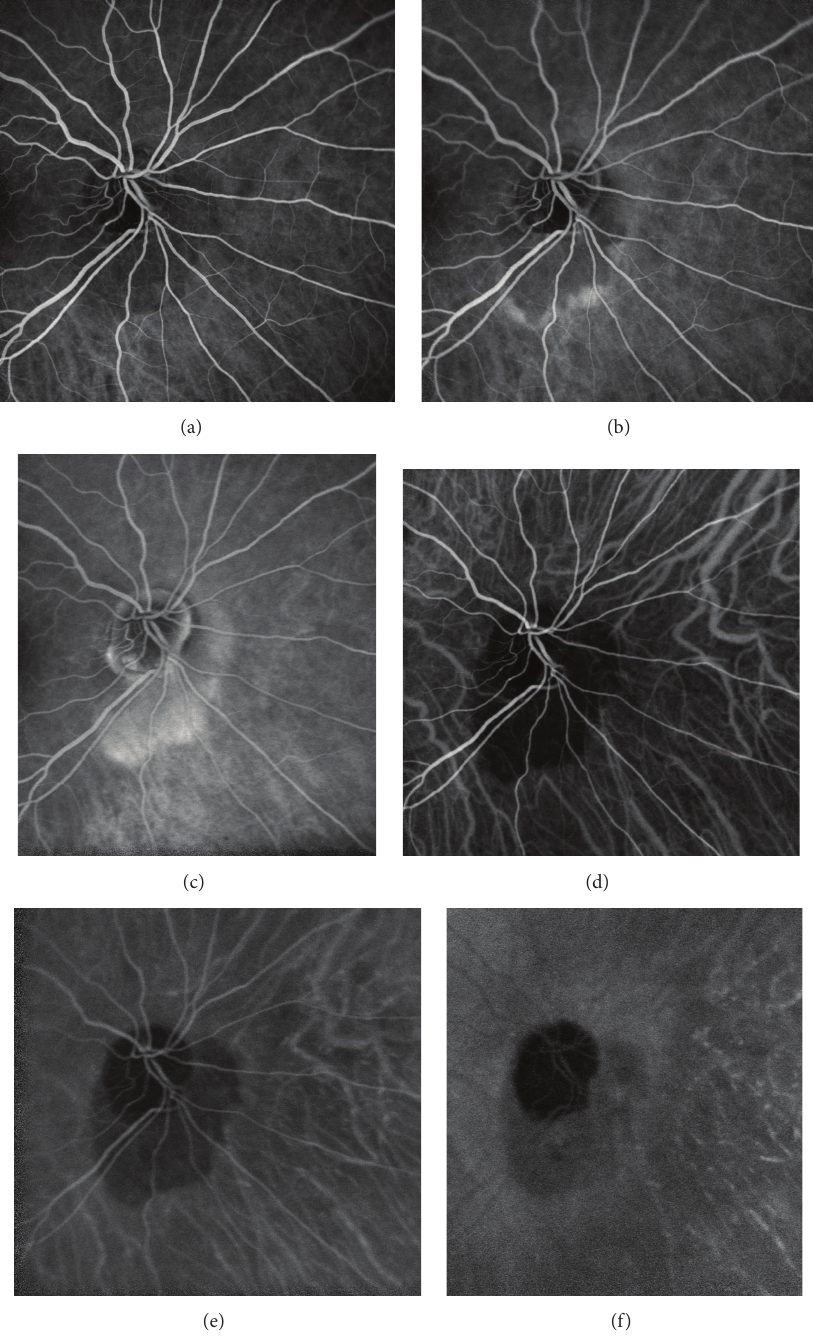
Figure 2: Fundus Fluorescein Angiography ((a) early stage at 1 minute, (b) intermediate stage at 3 minutes, and (c) late stage at 8 minutes) showing early hypofluorescence of the lesion with progressive late staining without any dye pooling. Indocyanine Green Angiography ((d) early stage at 2 minutes, (e) intermediate stage at 10 minutes, and (f) late stage at 20 minutes) showing the peripapillary cavitation to be hypofluorescent throughout the entire